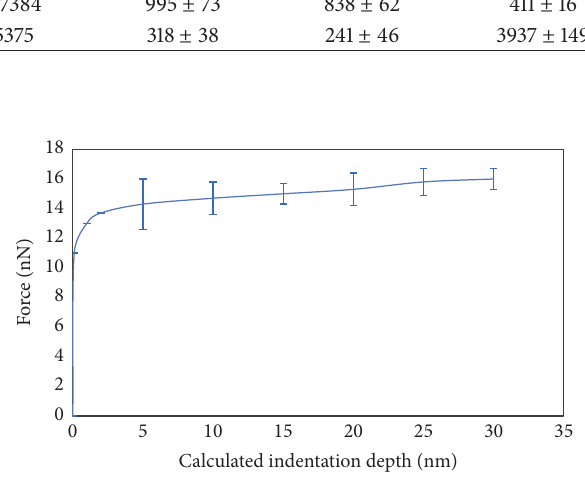
Figure 6: Force versus indentation depth of SPEEK from the retract portion of the force curve via